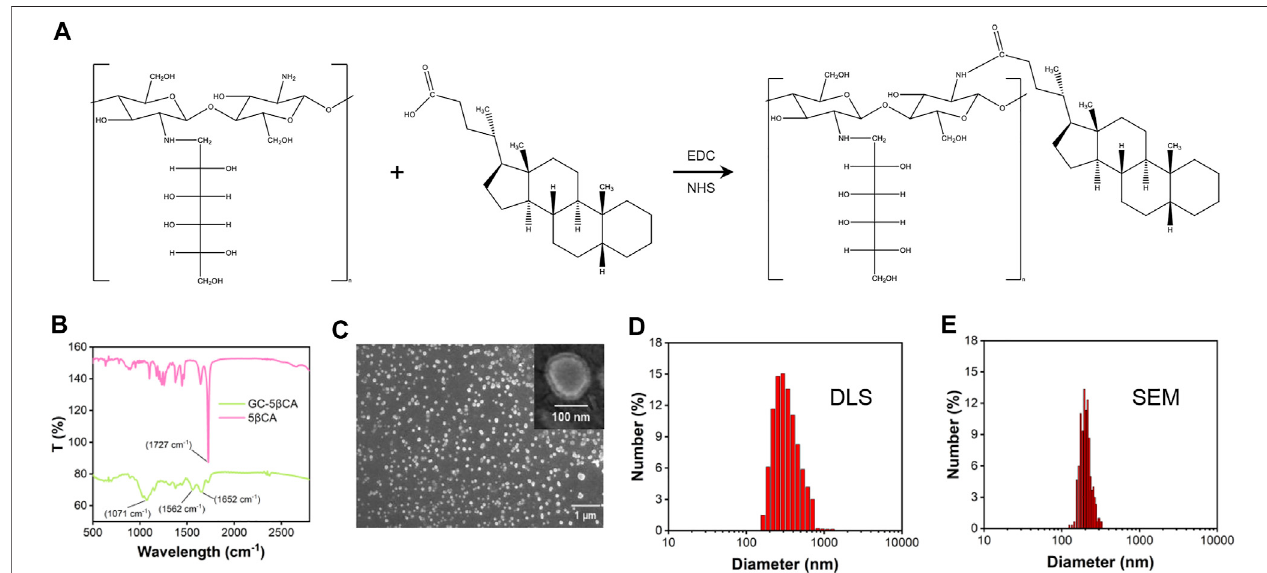
FIGURE 1 | Characterization of GC@ICG. (A) Chemical structure of GC-5 β CA conjugate. (B) The FTIR spectra of GC-5 β CA and 5 β CA. (C) SEM images of GC@ ICG. Scale bar: 1 μ m. Inset is enlarged image. Scale bar: 100 nm. (D) Size distribution of GC@ICG by DLS (E) Size distribution calculated from the SEM